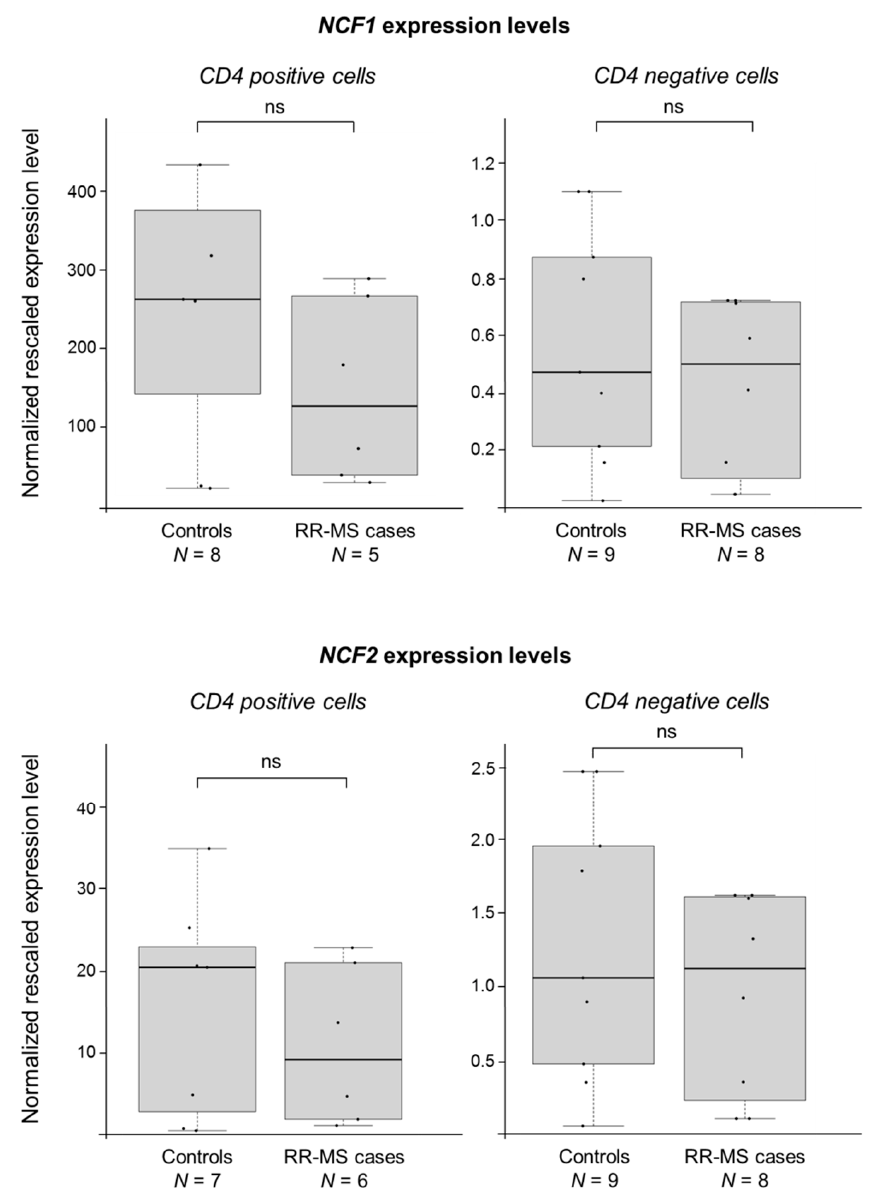
Figure 1. NCF1 and NCF2 do not show any significant difference between MS cases and controls. Boxplots show the expression levels of the NCF1 and NCF2 genes measured by semi-quantitative real-time RT-PCR in CD4 + and CD4 − cells (prepared from peripheral blood mononuclear cells, PBMCs). MS cases and controls belong to five multiplex Finnish families (comprising both male and female individuals). Boxes define the interquartile range; the thick line refers to the median. Results were normalized to expression levels of the HMBS and ACTB housekeeping genes and are presented as rescaled values. The number of subjects belonging to each group is indicated ( N ). The significance level of t -tests was in all cases not significant (ns).